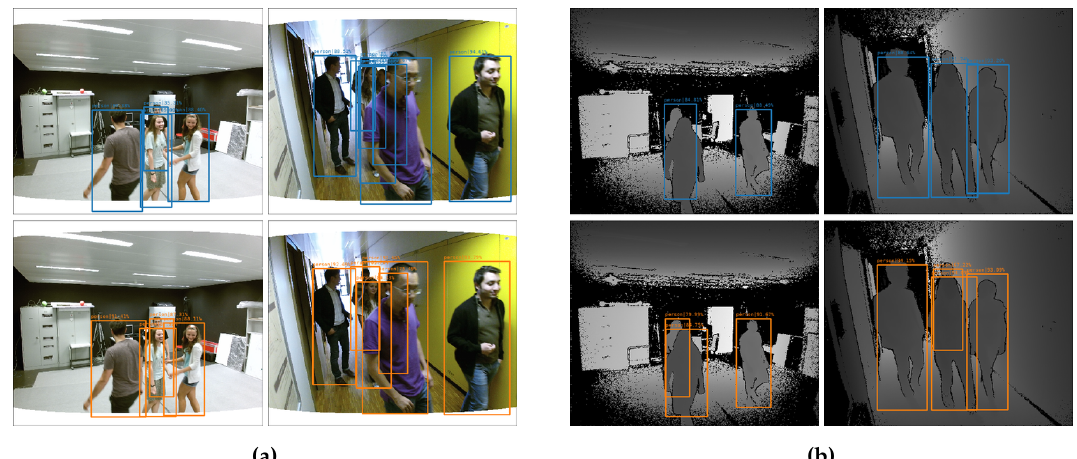
Figure 3. Example images from the test set of the Relabeled EPFL Pedestrian dataset. Detections from our best fusion model (RGBD_18) are shown in comparison with our baseline RGB and D models. ( a ) Resulting detections of our RGB model (top images—blue boxes) and best fusion model (bottom images—orange boxes). ( b ) Resulting detections of our Depth model (top images—blue boxes) and best fusion model (bottom images—orange boxes).